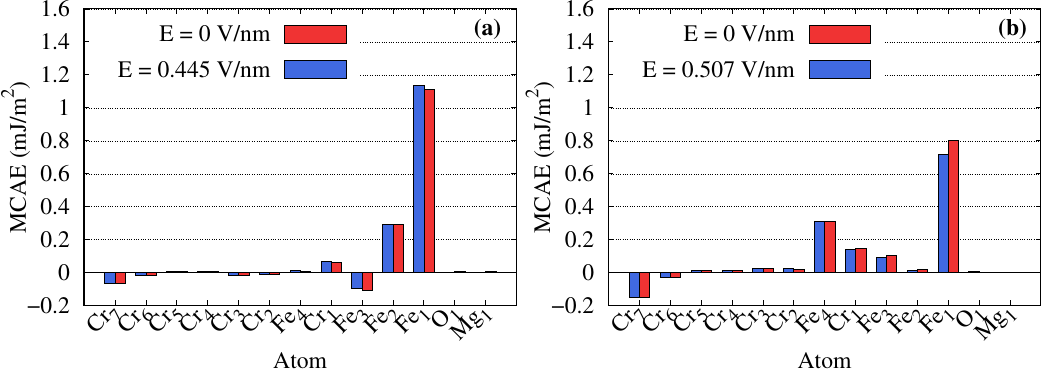
Figure 10. Atom-resolved MCAE at E = 0 V/nm and E = 0.445 V/nm for ( a ) η Fe = +0.3% and E = 0.507 V/nm for ( b ) η Fe = −